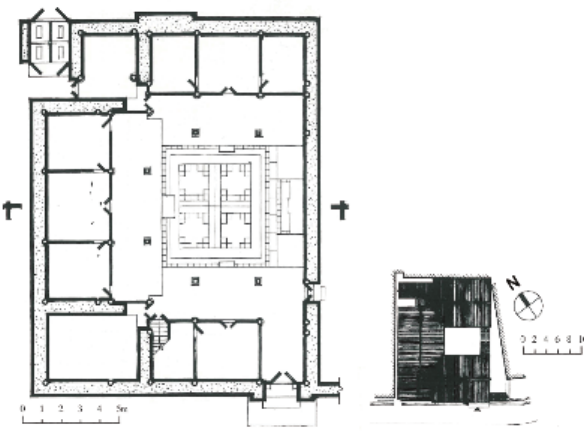
Figure 15. Flo or plan of ground level of Case A (left ); site plan of Case A. Th e Lis House, 41, Xinghuo Lane, Qiyi Street built in 1938 (right) (source: Zhu, 2020; personal communication,